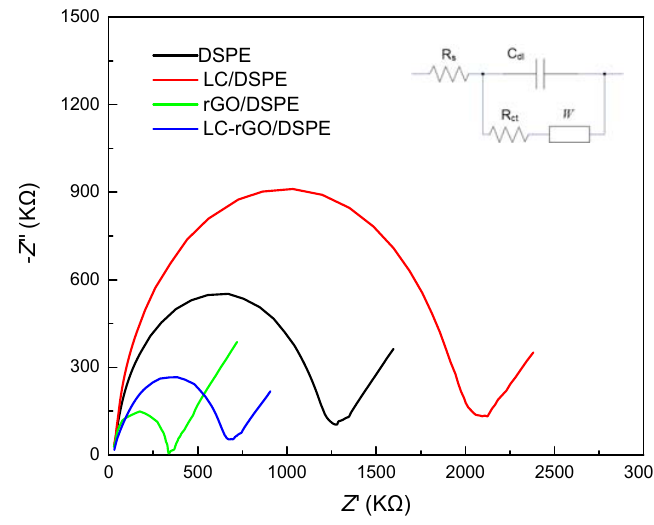
Figure 3. Electrochemical impedance spectroscopy of the DSPE, LC/DSPE, rGO/DSPE and LC ‐ rGO/DSPE in 5 mmol/L [Fe(CN) 6 ] 3 ‐ /4 − and 0.1 mol/L KCl with frequencies from 1 to 10 5 Hz.